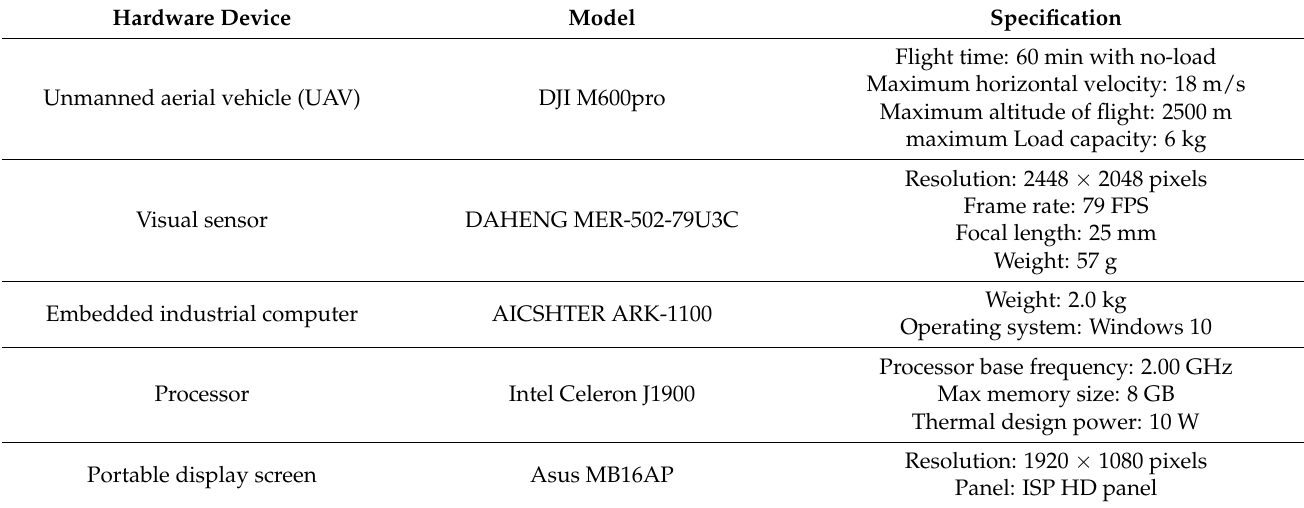
Figure 2. Schematic diagram of the developed automatic insulator inspection system. Table 2. Hardware devices used in this study for inspection of transmission